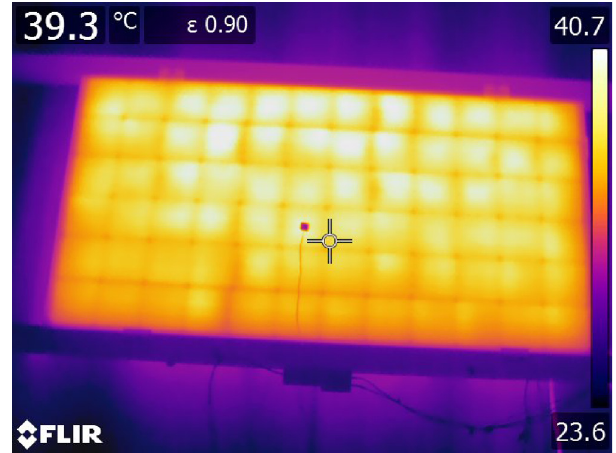
Fig. 4. Infrared thermography image of the HJT module under backpowering with short-circuit current. No formation of hot spots visible at the temperature measurement